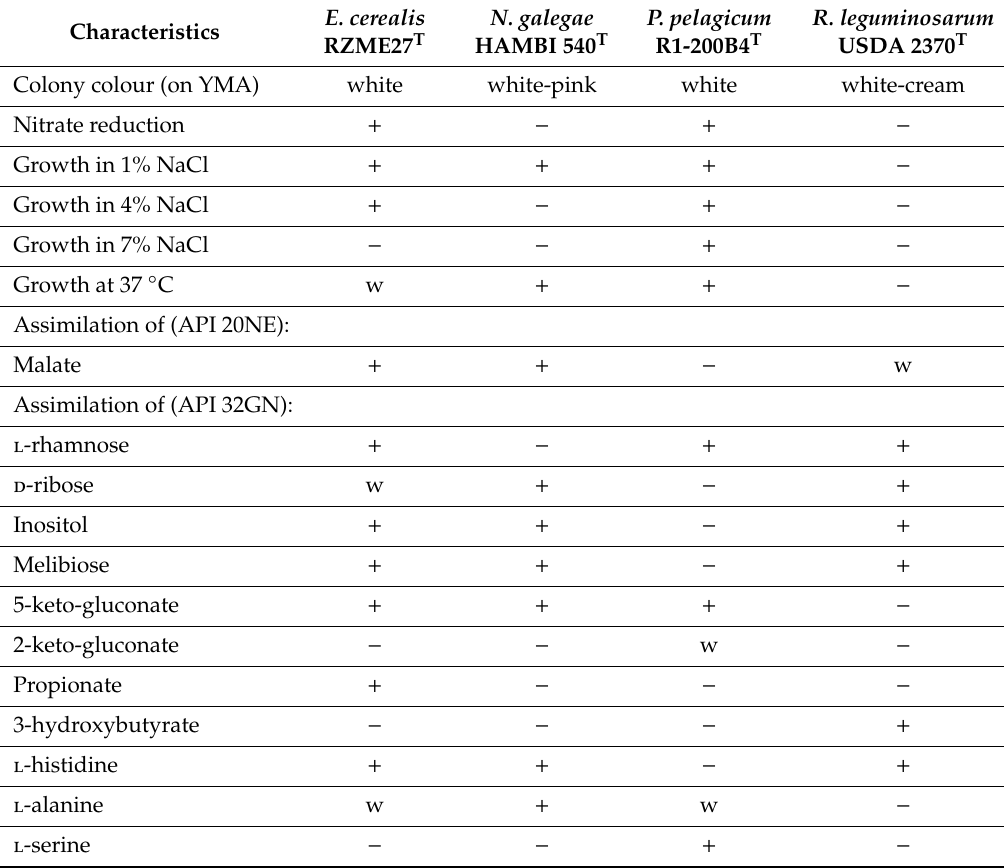
Table 4. Di ff erential phenotypic characteristics of Endobacterium cerealis , its closest related genera and the type species of the type genus of family Rhizobiaceae